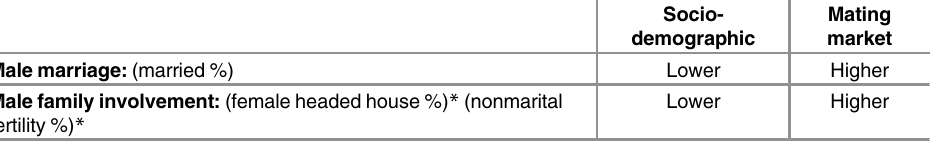
Socio- Mating demographic market